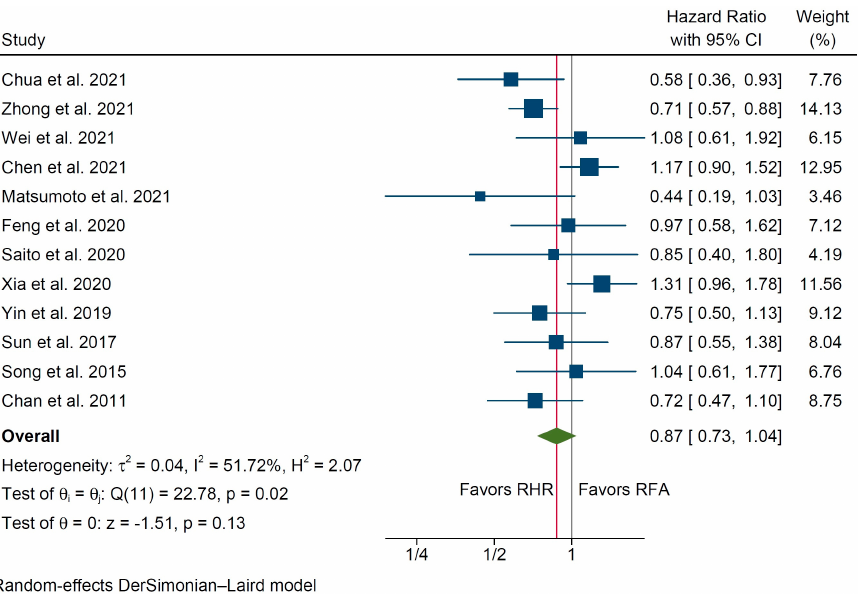
Figure 3. Forest plot for Disease-Free Survival of patients undergoing repeat hepatic resection (RHR) versus radiofrequency ablation (RFA) of recurrent hepatocellular carcinoma [22 – 28,30 – 32,34,36].